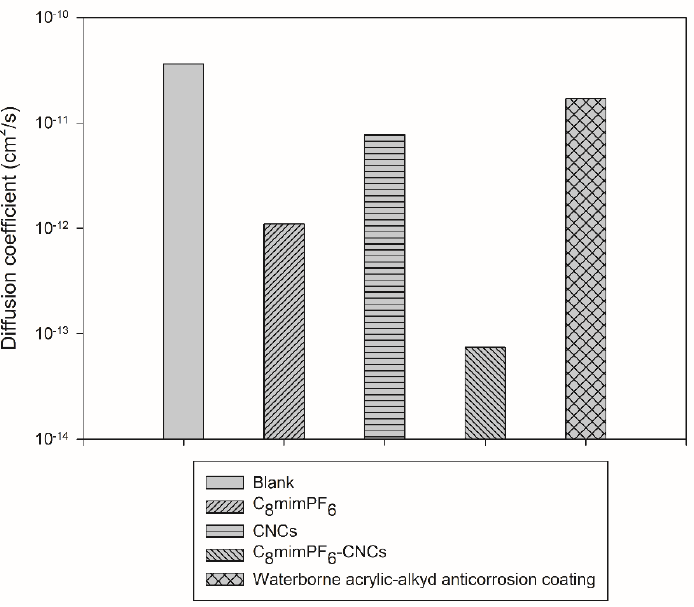
Figure 6. Diffusion coefficients of various coated samples.